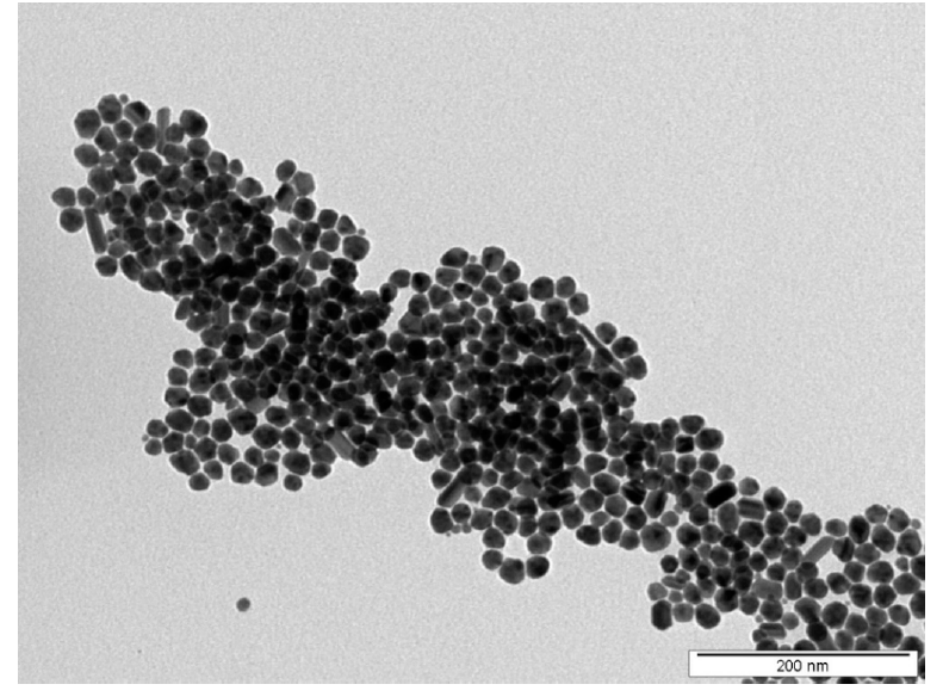
Figure 1. TEM image of synthesized AgNPs used in the immobilization process.